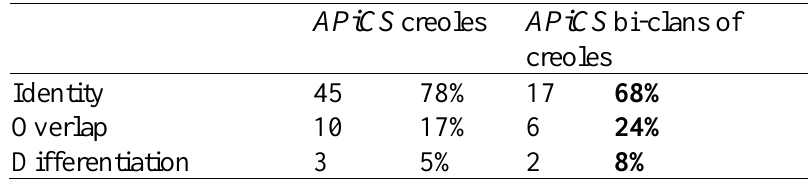
Table 8. Comitatives and